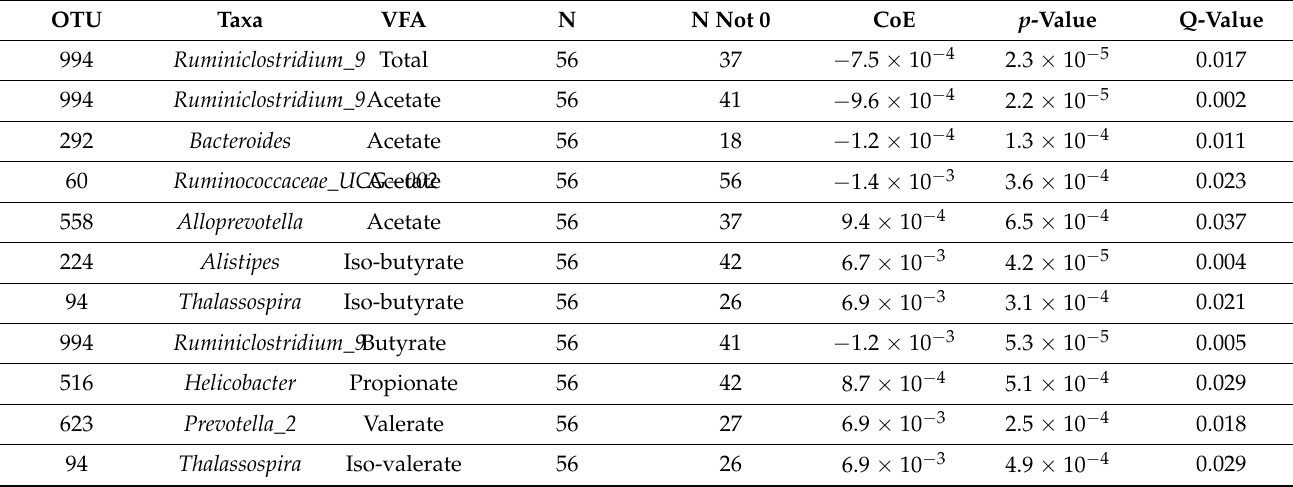
Table 4. Multivariate linear regression analysis of gut microbiota relative abundancies and volatile fatty acid concentrations found in feces 1